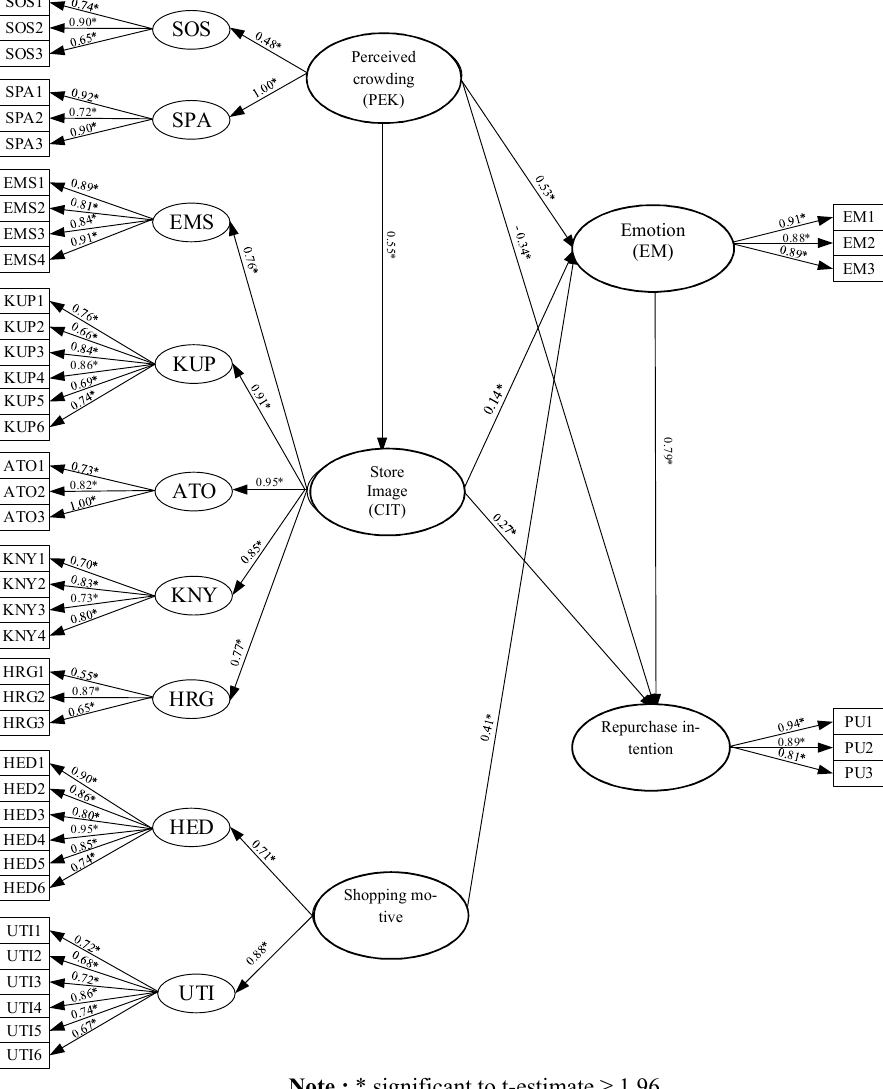
Fig. 2. Standardized loading factor of SEM